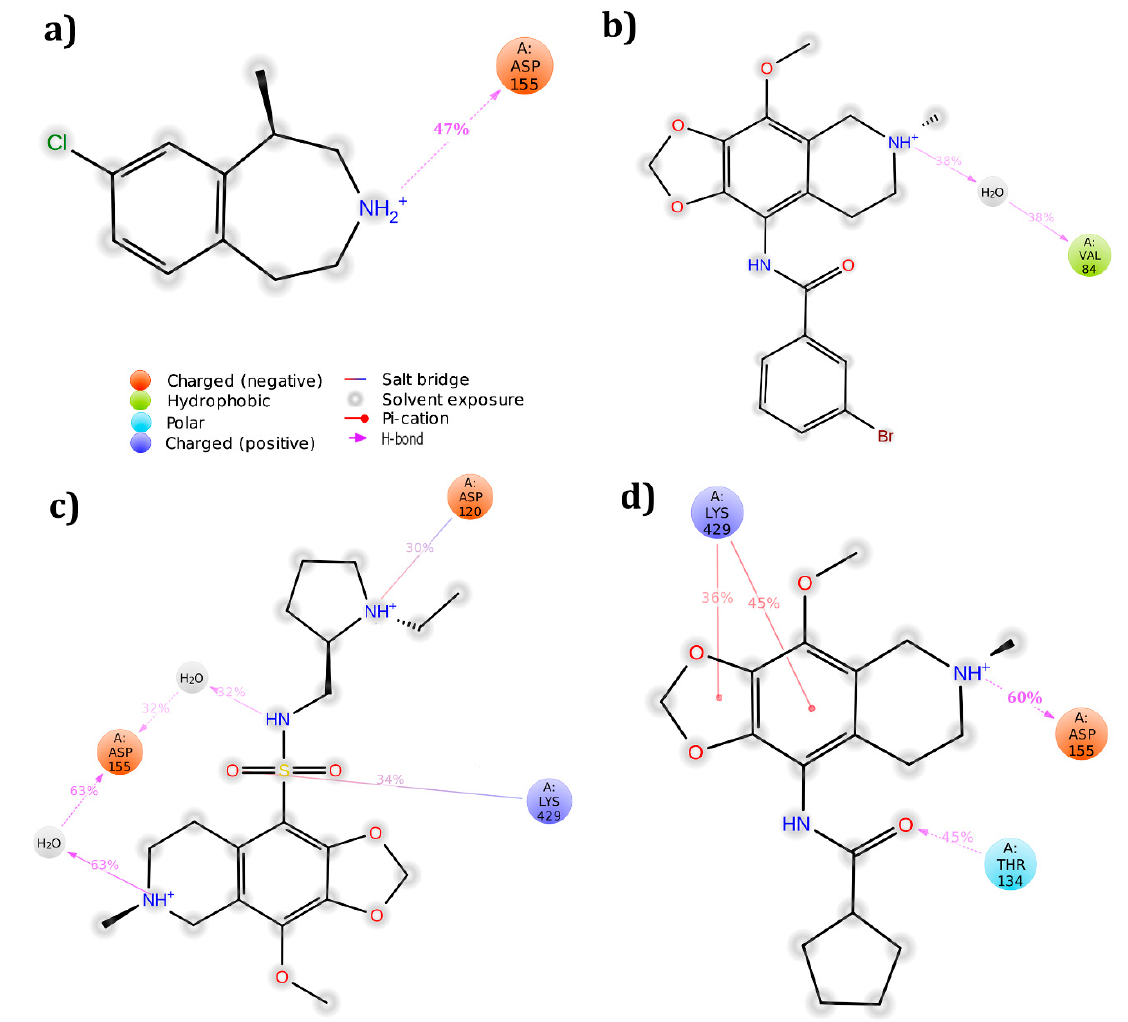
Figure 5. Binding modes of molecules with 5HT 2A receptor after simulation studies: ( a ) Lorcaserin; ( b ) ZINC32123870; ( c ) ZINC40312983; and ( d ) ZINC32124535. Table 3. Interactions of three potential hits along with known drug during the docking and simulation studies along with PRIME energy calculations.